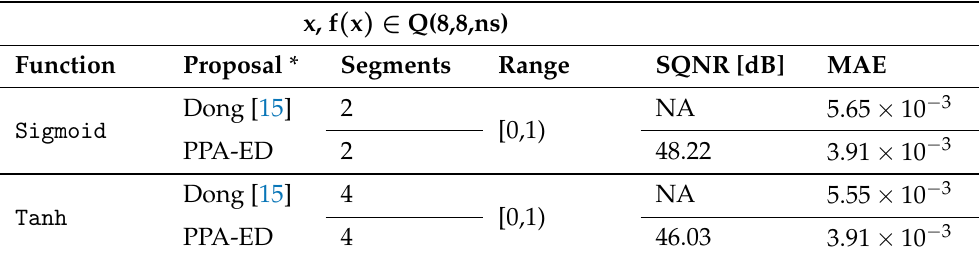
Table 11. Performance comparison for the implemented AFs based on PLAC and PPA-ED methodologies.